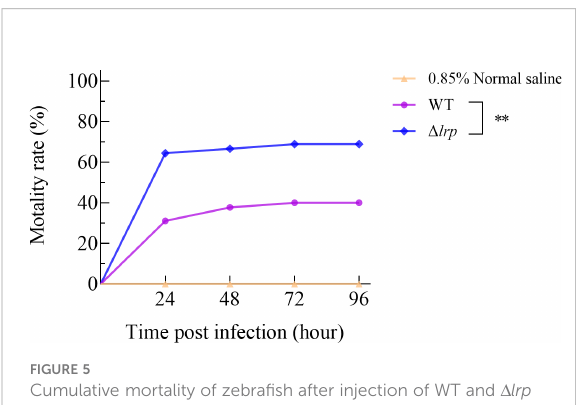
FIGURE 5 Cumulative mortality of zebra fi sh after injection of WT and D lrp strains. Cumulative mortality was recorded every 24 h. Differences in cumulative mortalities were analyzed by Log-rank (Mantel-Cox) test (**, P